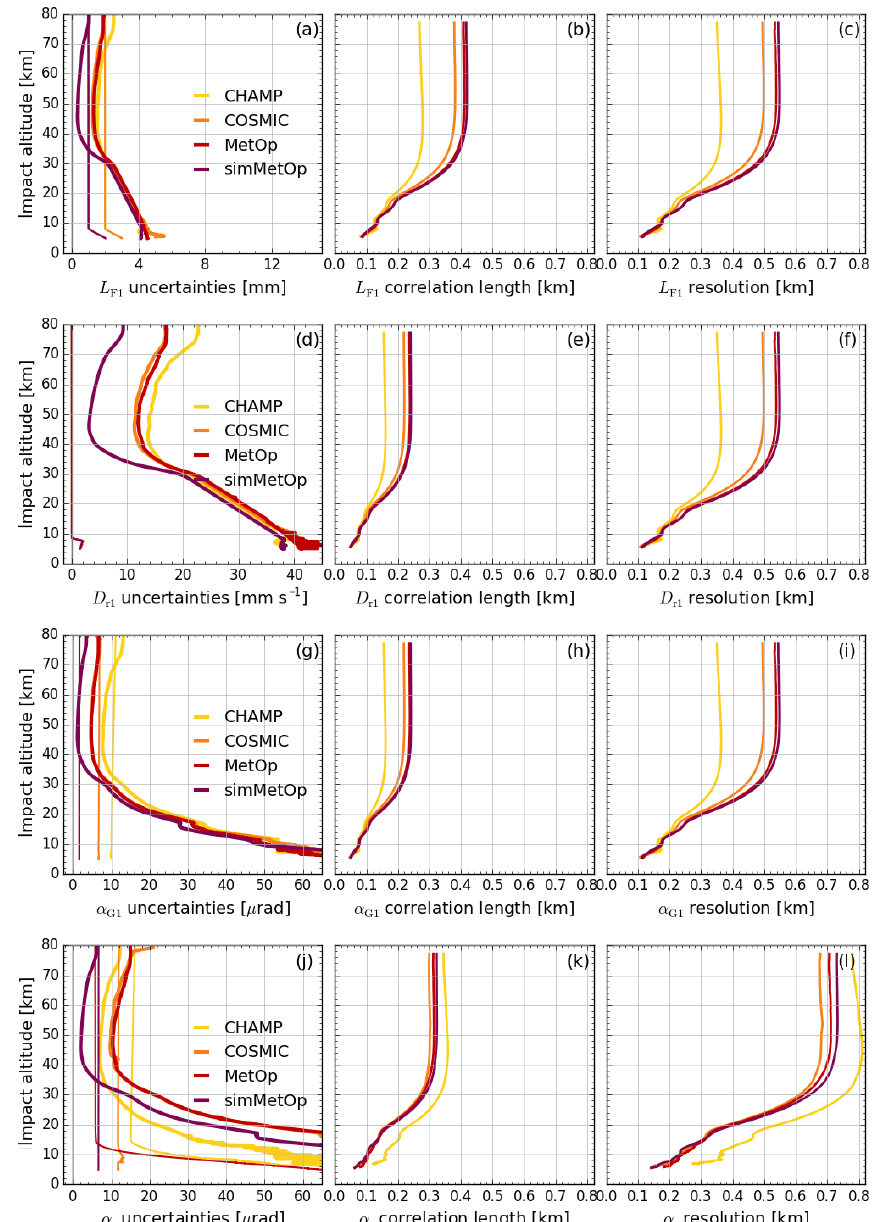
Figure 11. Uncertainty propagation results for real-data ensembles from 15 July 2008 for output profiles of the leading channel ( f T1 , GPS L1 frequency). The first row shows results for L F1 (a–c) , the second for D r1 (d–f) , the third for α G1 (g–i) , and the fourth for α r (j–l) . The different ensemble mean profiles are shown in colors (CHAMP, yellow; COSMIC, orange; MetOp, red; and simMetOp, violet). Left column: mean random uncertainty u r (heavy) and mean systematic uncertainty u s (light) profiles (a, d, g, j) ; the latter is shown as 10 × u s X r X r a ) and 100 × u s (d, g, j) for enabling visibility of these small quantities. Middle column: correlation length profiles l X r (b, e, h, k) . Right X r column: vertical resolution profiles w X r (c, f, i, l)